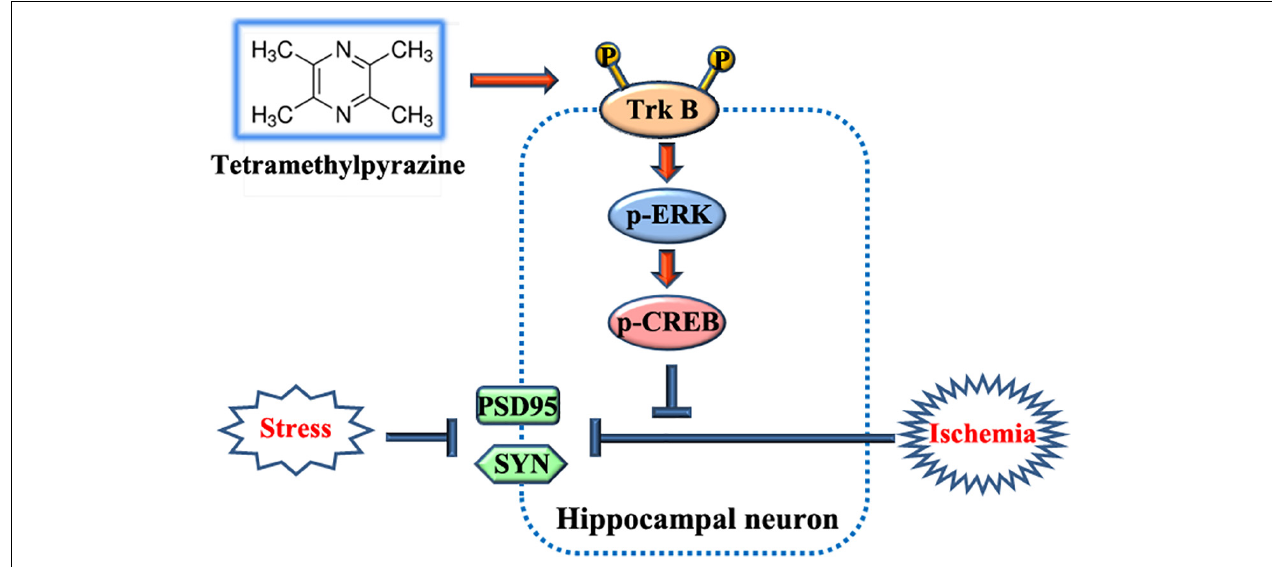
FIGURE 11 | Schematic diagram for the beneficial effects and mechanisms of